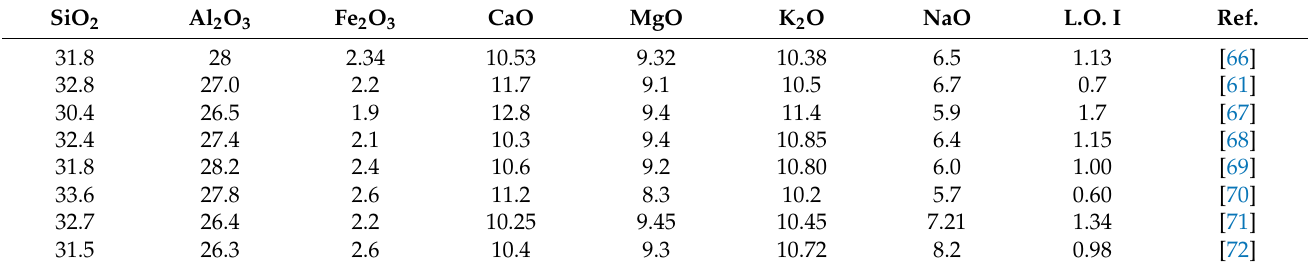
Table 2. Chemical compounds of WWA from past